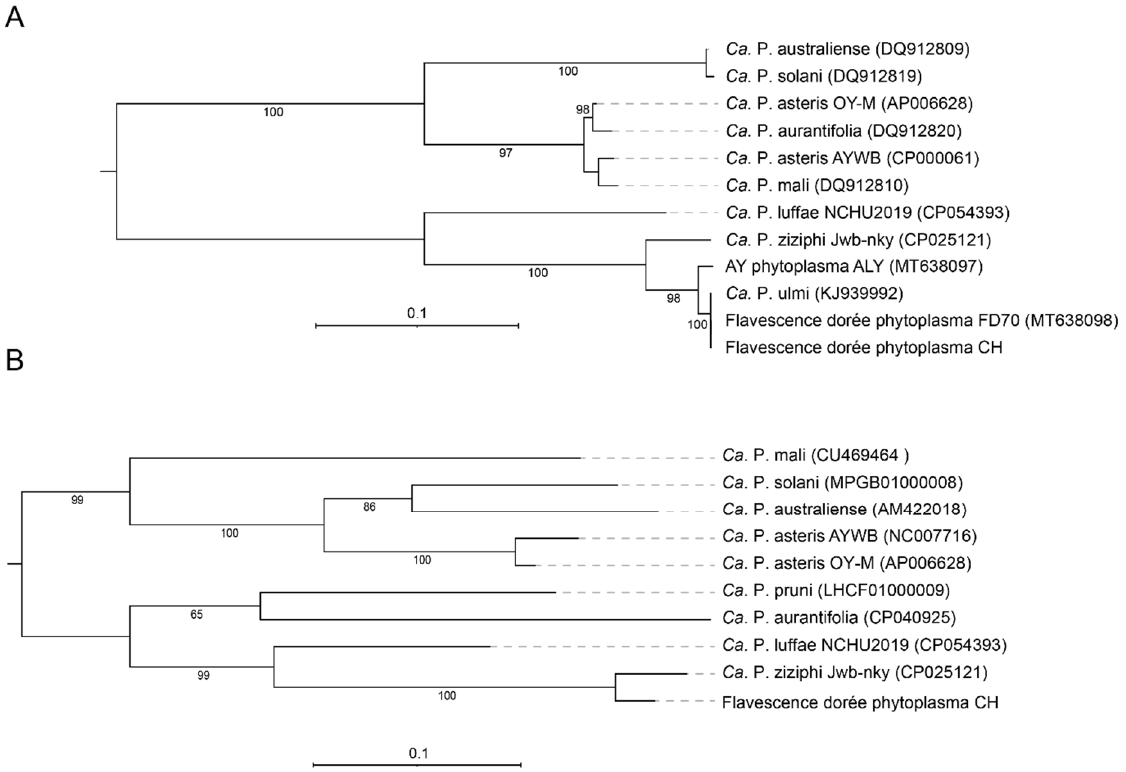
Figure 5. Maximum likelihood phylogeny based on nucleotide sequences of ( A ) groEL and ( B ) smpB genes. The numbers on branches indicate the level of bootstrap support (500 replicates). Support values above 65% are labeled. The scale bar shows the number of substitutions per site.